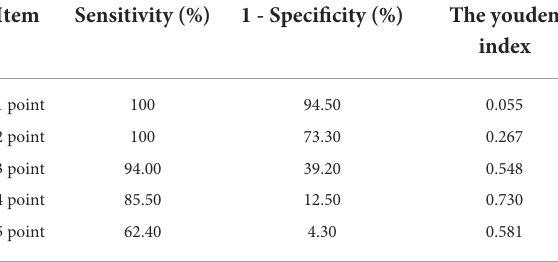
TABLE 6 Comparison of predictive effect of different cut-off points on admission in the